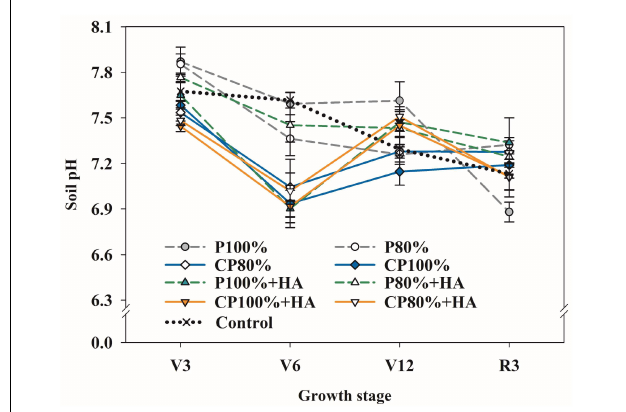
FIGURE 2 | Changes of soil pH in different fertilization treatments. Control, no P fertilizer added; P 100%, diammonium phosphate (DAP) at 75 kg P 2 O